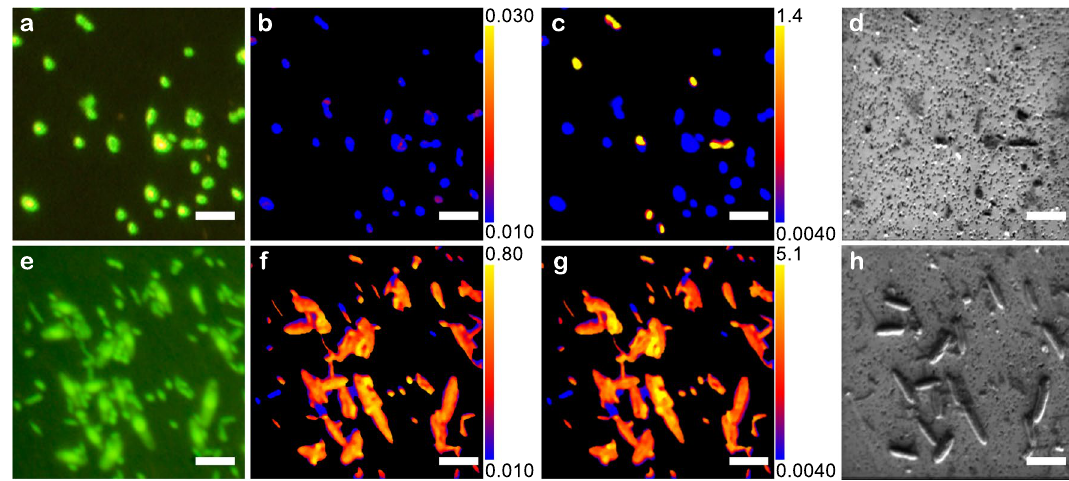
Fig. 6 Detection of substrate incorporation into microbial cells revived in 101.5 Ma sediment. Cells from incubations with 13 C-bicarbonate and 15 N ammonium ( a , b , c , d ) and 13 C, 15 N-Amino acid mix ( e , f , g , h ) are shown. a , e SYBR Green I-stained cells under fluorescence microscopy. b , c , f , g Ratio images of 13 C/ 12 C ( b , f ) and 12 C 15 N/ 12 C 14 N ( c , g ) ratios of the same regions imaged in a and e , demonstrating locations of 13 C and 15 N incorporation. Color scale range of the ratios are shown as number appearing at top and bottom of the color bar. The background membrane region, which is identified by fluorescence images, is excluded from the ratio calculation and shown as black background. d , h Secondary electron (NanoSIMS) images of the same region in a and e . Bars represent 5 µm. Adopted from Morono et al.